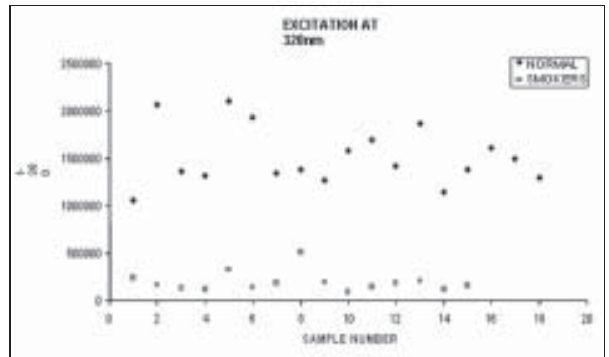
Fig. 5 - Scatter plot of intensity value at 380nm Vs sample number for normal and tobacco smokers from fluorescence emission at 320nm excitation